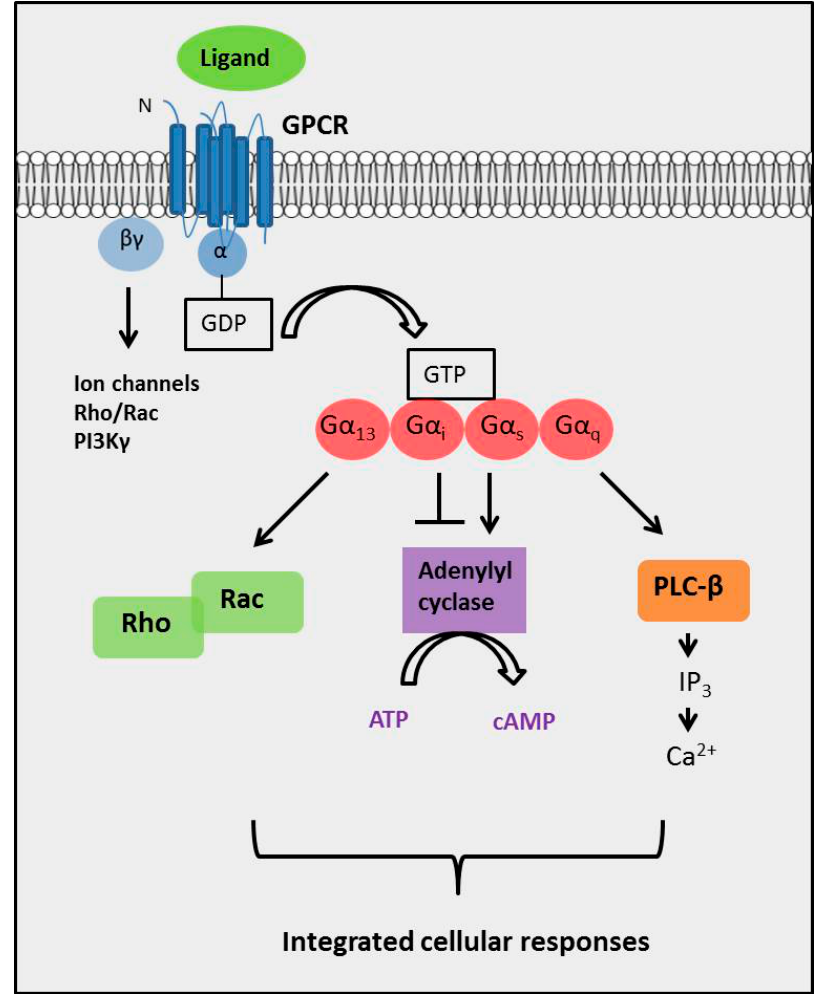
Figure 1. GPCRs signal through heterotrimeric G proteins. GPCRs transmit extracellular signals across the plasma membrane to intracellular effectors via heterotrimeric G proteins [22]. G proteins belong to the GTPase family and are composed of three subunits, α , β and γ , in which the β and γ subunits form a stable dimeric complex, the βγ -subunit [44]. Upon agonist stimulation, the GPCR undergoes rapid conformational changes that expose intracellular sites that interact with and activate G proteins [45]. This catalyzes the dissociation of GDP bound to the G α subunit and its replacement with GTP, in turn leading to the dissociation of G α from the βγ -subunit [46]. Both G α -GTP and G βγ -subunit complexes are then freely available to activate downstream effectors [28,47,48]. G α subunits have been classified into four families: G α s , G α i/o , G α q and G α 12/13. The G α subunits activate